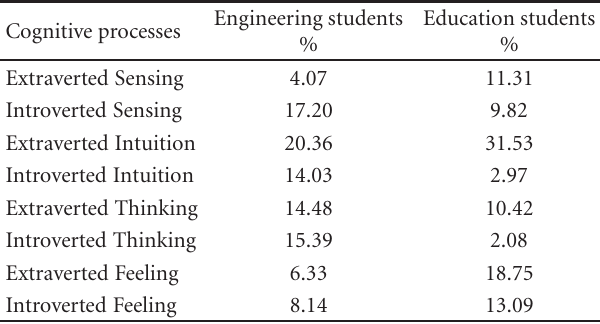
Table 2: Di ff erences between Engineering and Education students preferring various dominant cognitive